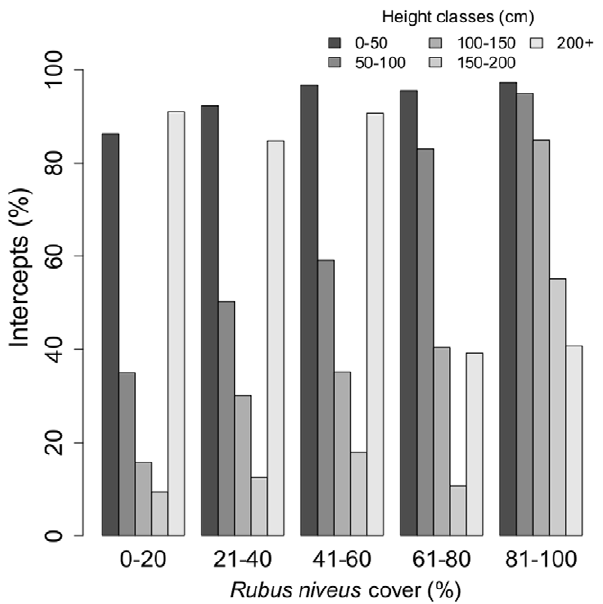
Figure 6. Relationship between R.niveus cover categories and the proportion of light reaching the understorey (propor- tion=light intensity at 0.5 m/light intensity at 2 m).